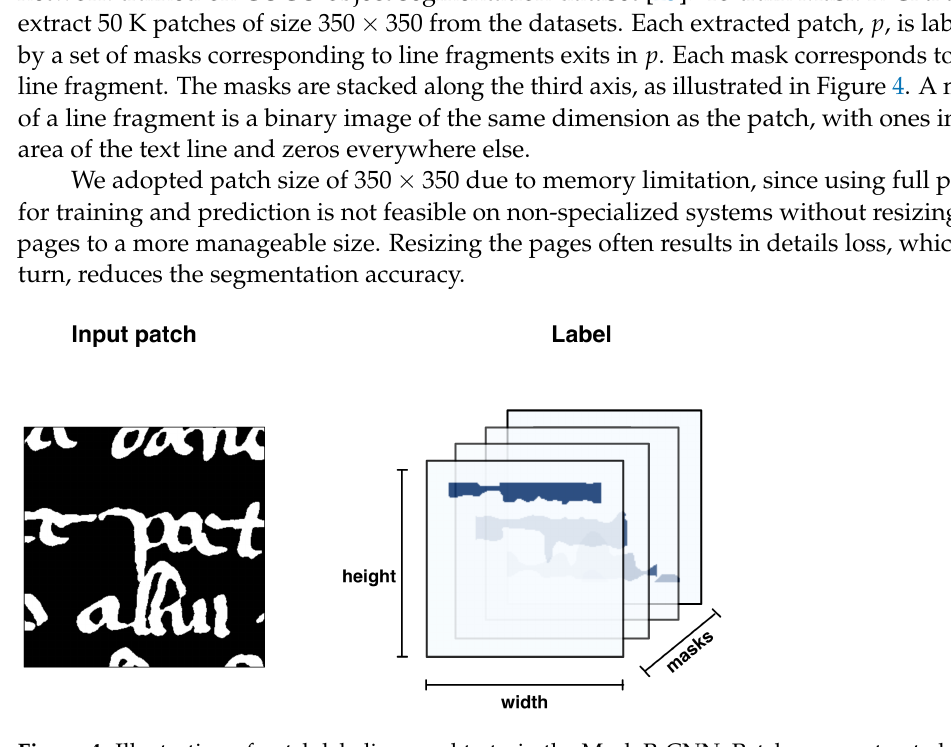
Figure 4. Illustration of patch labeling used to train the Mask R-CNN. Patches are extracted from page images and labeled by stacking the text line mask along the channel